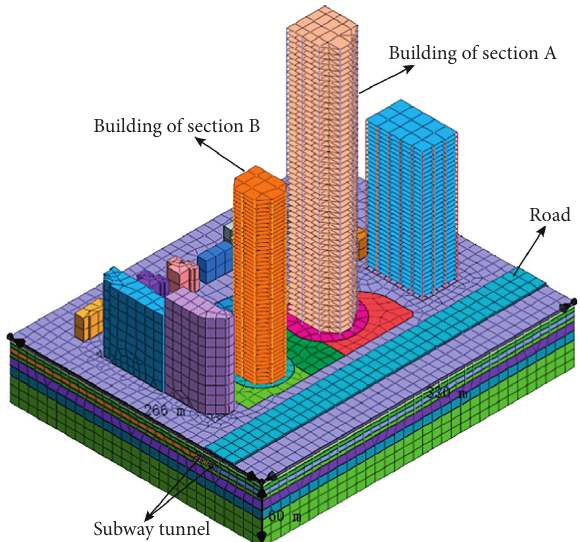
Figure 13: GTS NX integral model.